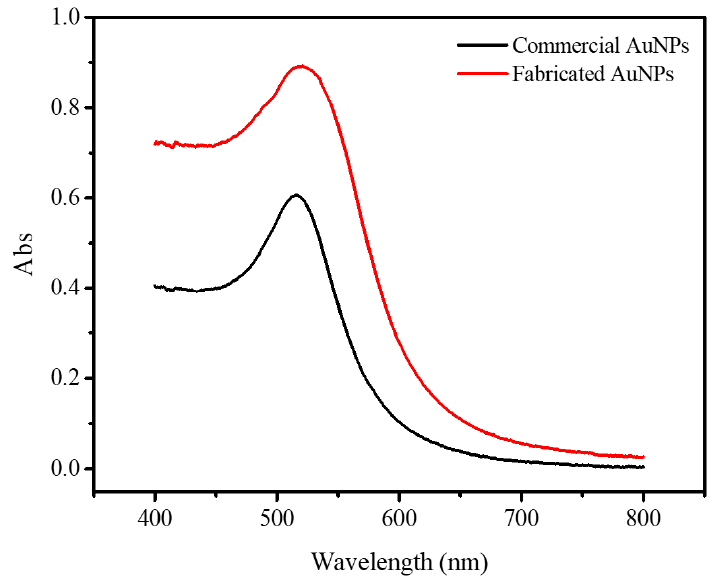
Figure 1. Comparative UV-absorbance spectra of commercial with fabricated AuNPs.